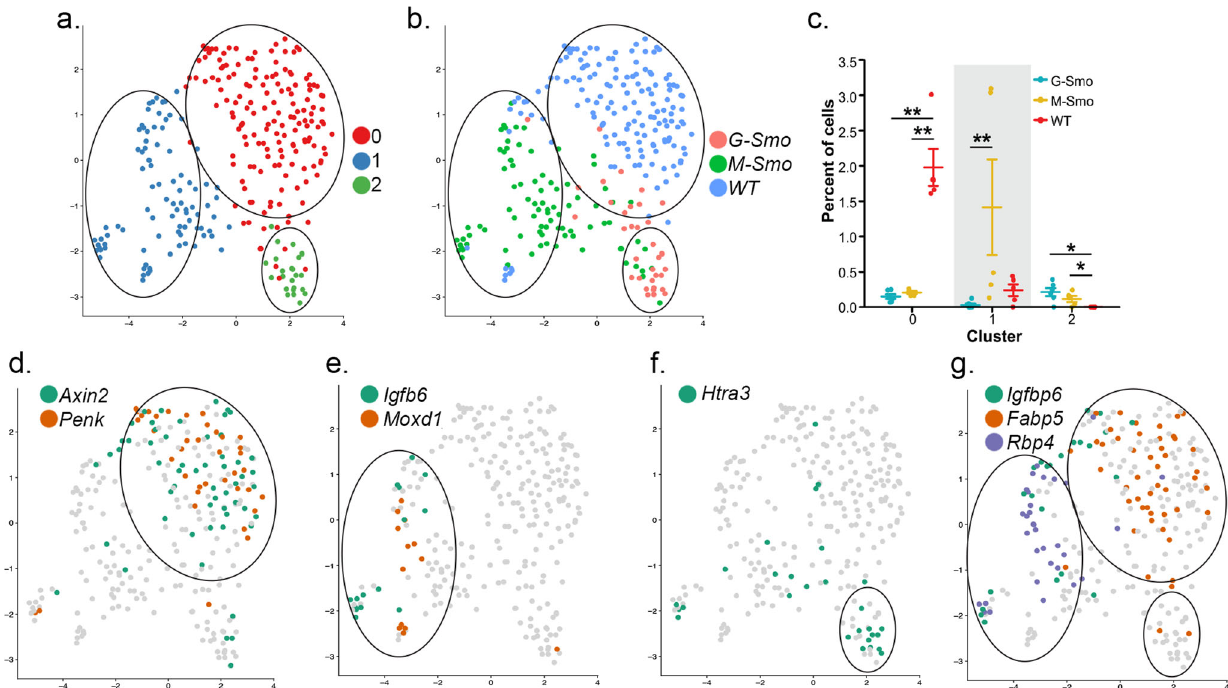
Fig. 8 Different fi broblastic populations in G-Smo and M-Smo tumors. a UMAP showing fi broblastic cells from G-Smo , M-Smo , and P7 WT, with clusters color-coded and circled. b genotype color-coded on the UMAP from a . Circles indicate the positions of the clusters. c Comparison of the indicated cluster populations in G-Smo , M-Smo , and P7 WT. Dots represent values for individual replicates, bars indicate the means and whiskers indicate the SEM. d – g Feature plots on UMAP from a , showing expression of d Cluster F 0 markers Axin2 and Penk , e Cluster F 1 markers Igfbp6 and Moxd1 , f Cluster F 2 marker Htra3 , and g retinoic acid signaling components Crabp2 , Fabp5, and Rbp4 . Student ’ s test was used in c